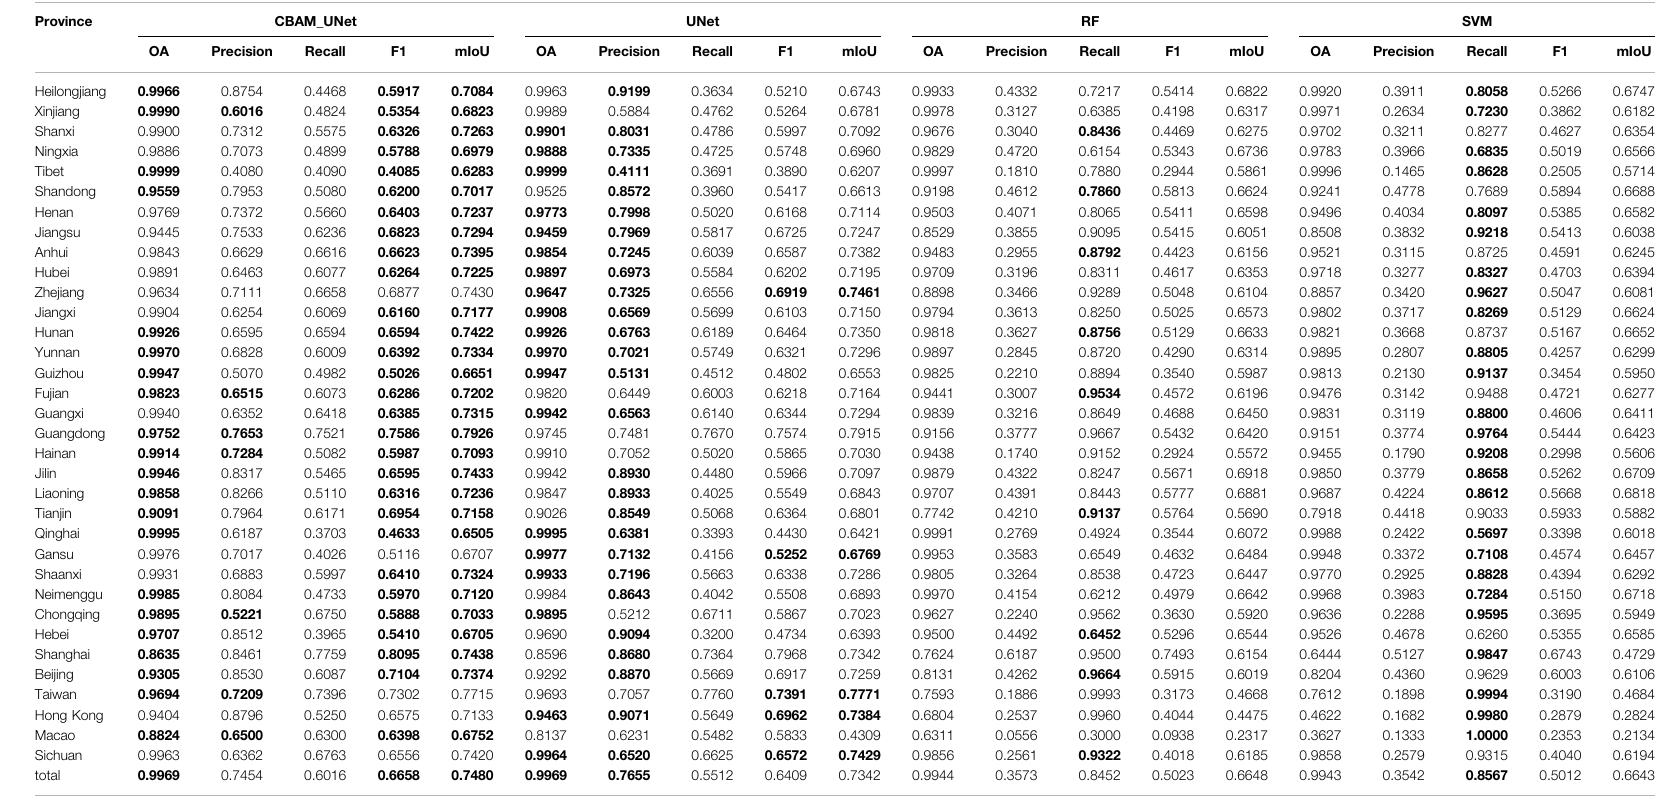
TABLE 3 | Accuracy assessment of urban built-up area results.